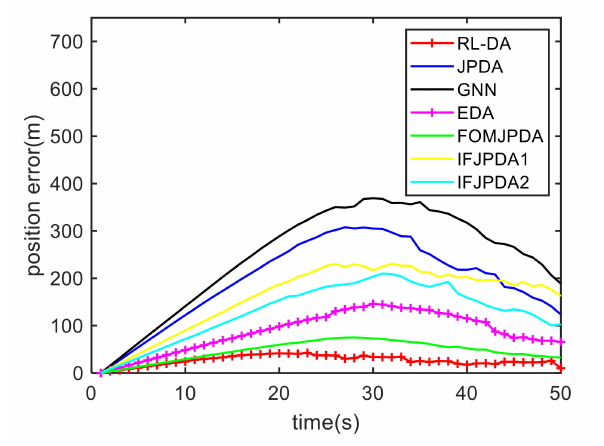
Figure 27. Comparison of the position errors for Target 3 in Case